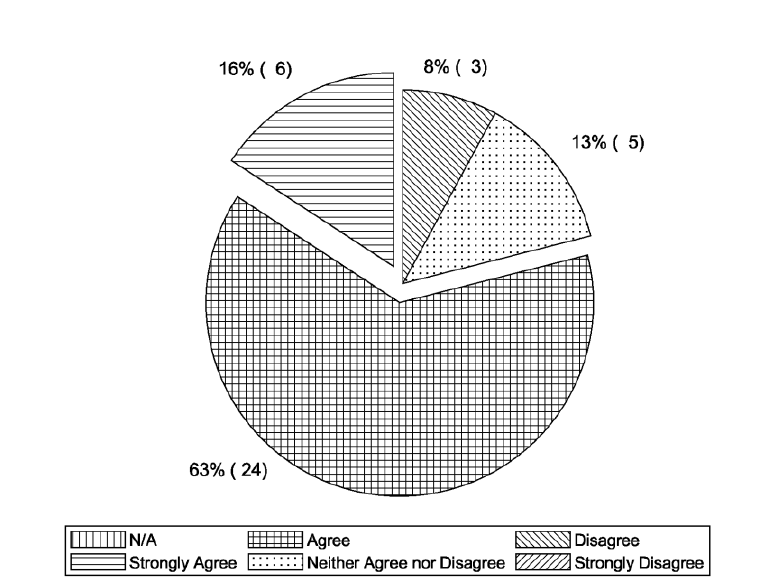
Fig. 11. Presentations help students strengthen the decision to study the engineering major that they